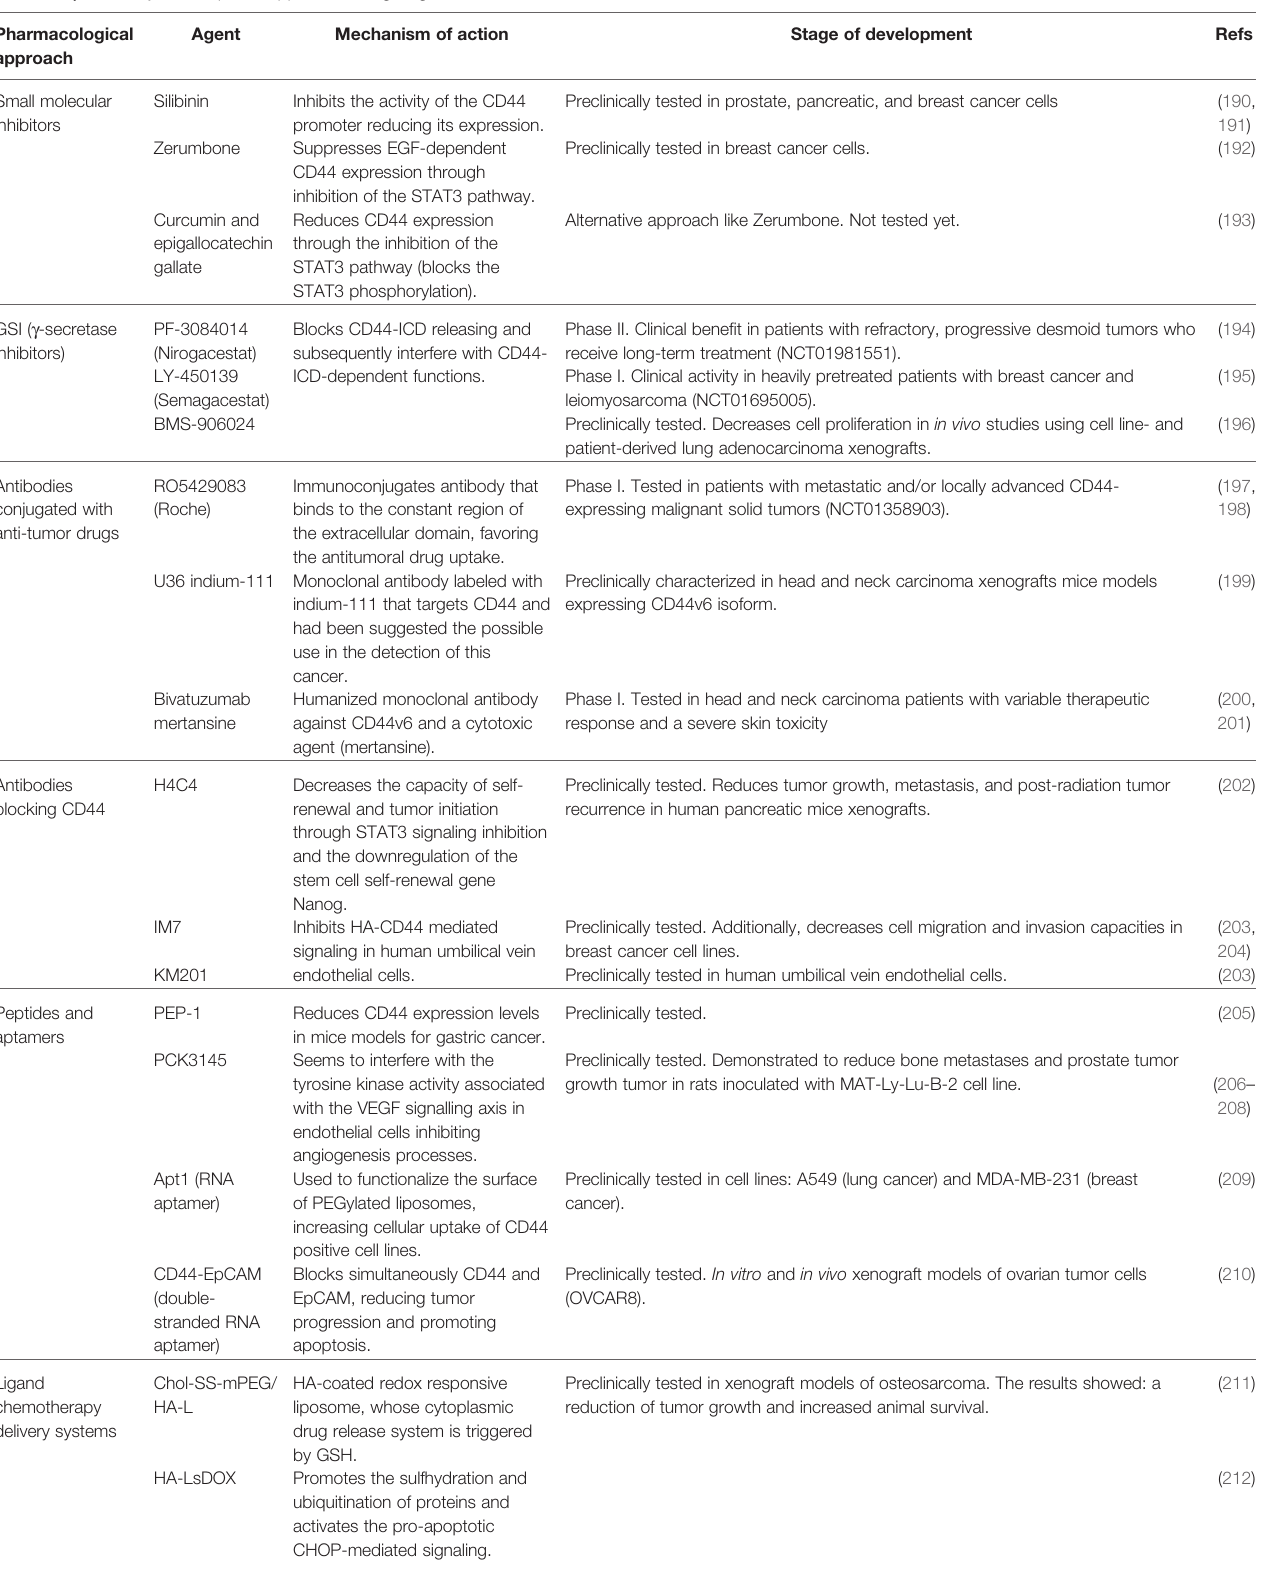
TABLE 2 | Summary of therapeutic approaches targeting